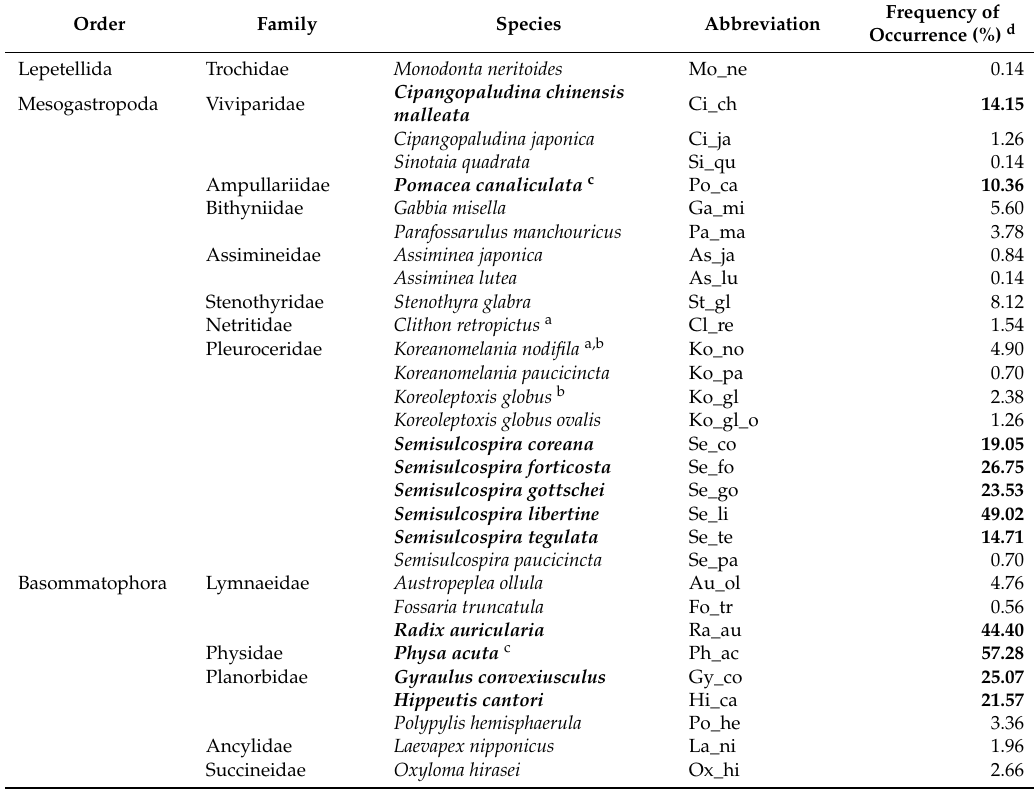
Table 2. Gastropod species and their frequency of occurrence (%) in the dataset. Species with a frequency of occurrence of over 10% are indicated in